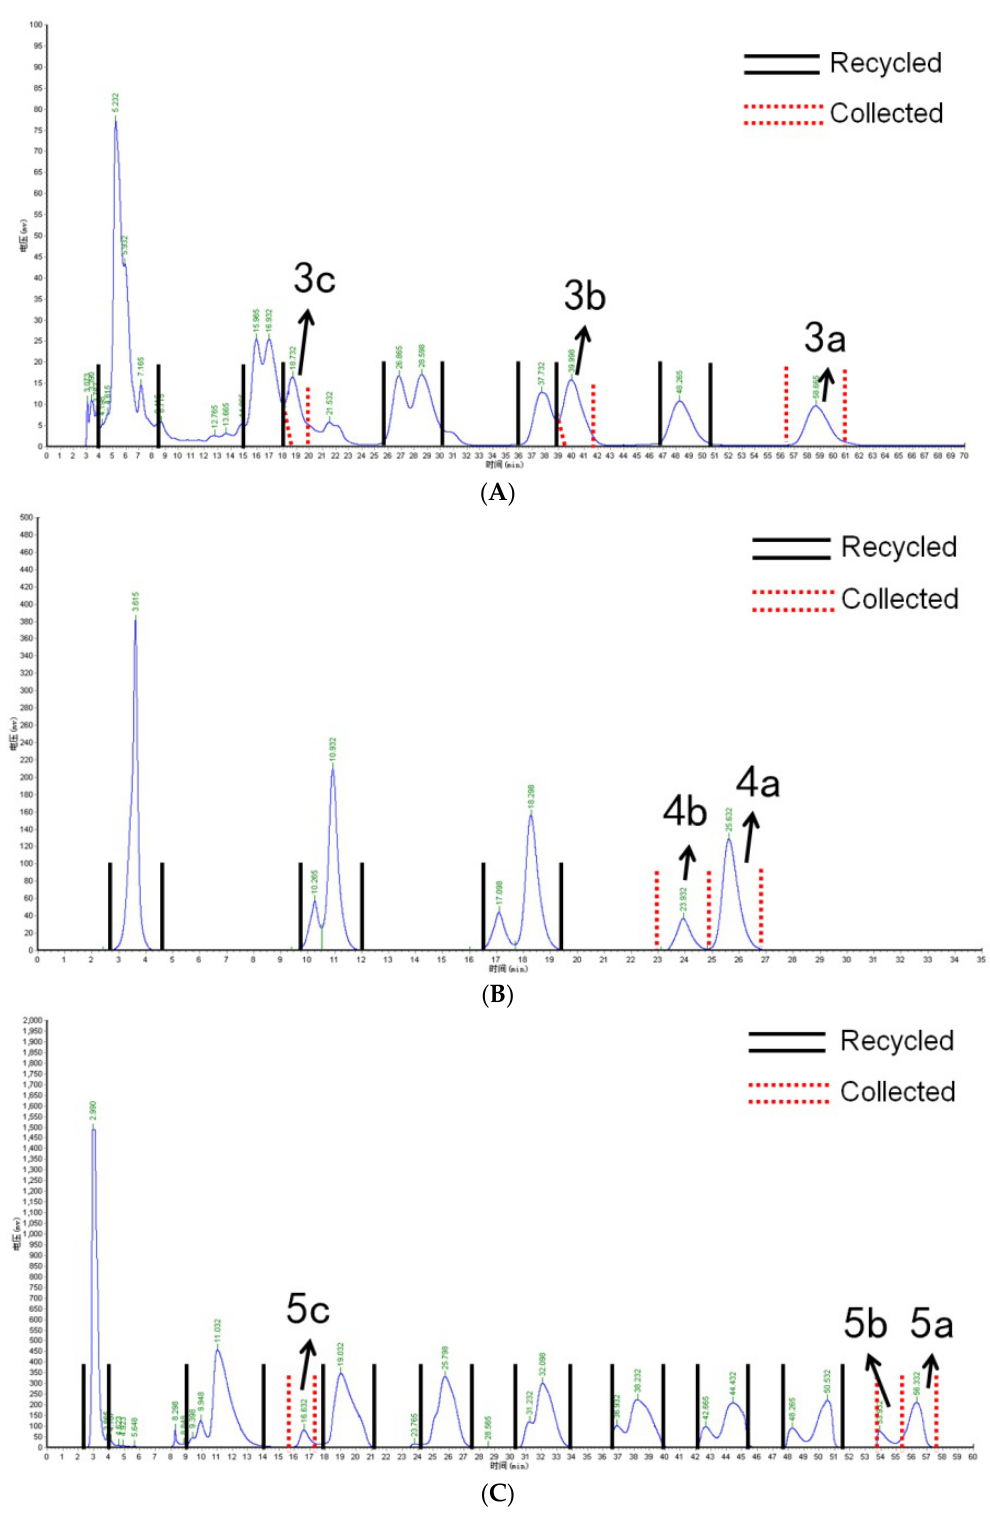
Figure 4. ( A – C ) respectively represent the recycling preparative HPLC chromatogram of fractions 3, 4, and 5.